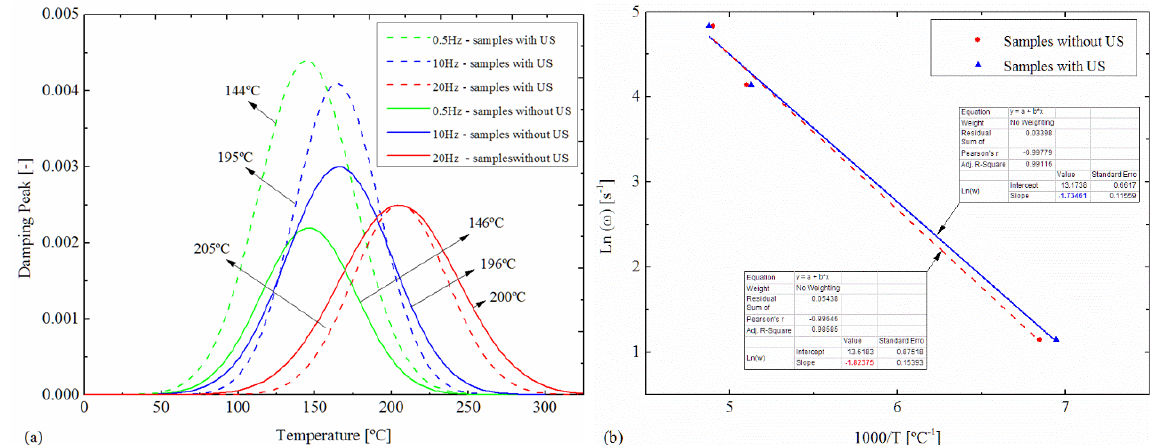
Figure 7. Damping peaks ( a ) and Arrhenius plot ( b ) in AZ91